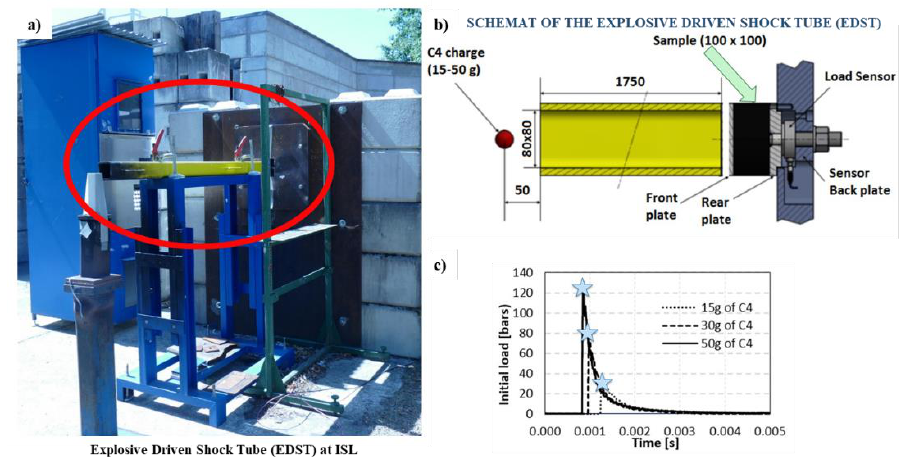
Fig. 2. The test stand of the Explosive Driven Shock Tube: a) side view, b) schema of the EDST, c) initial impulse profiles of the load dependent on the used